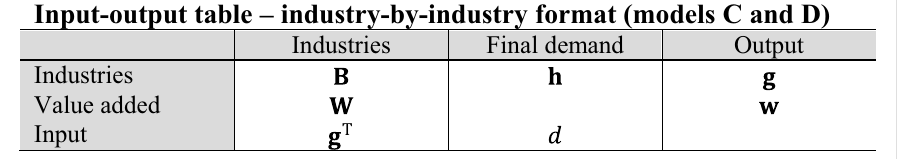
Fig. 3 Format of the two forms of IOT with the definition of the symbols. Based on Eurostat (2008, p. 348)